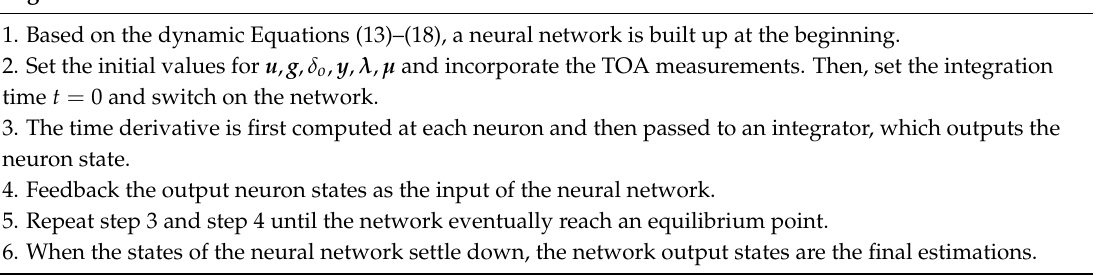
t . Figure 1. The structure of the proposed LPNN with unknown t o o